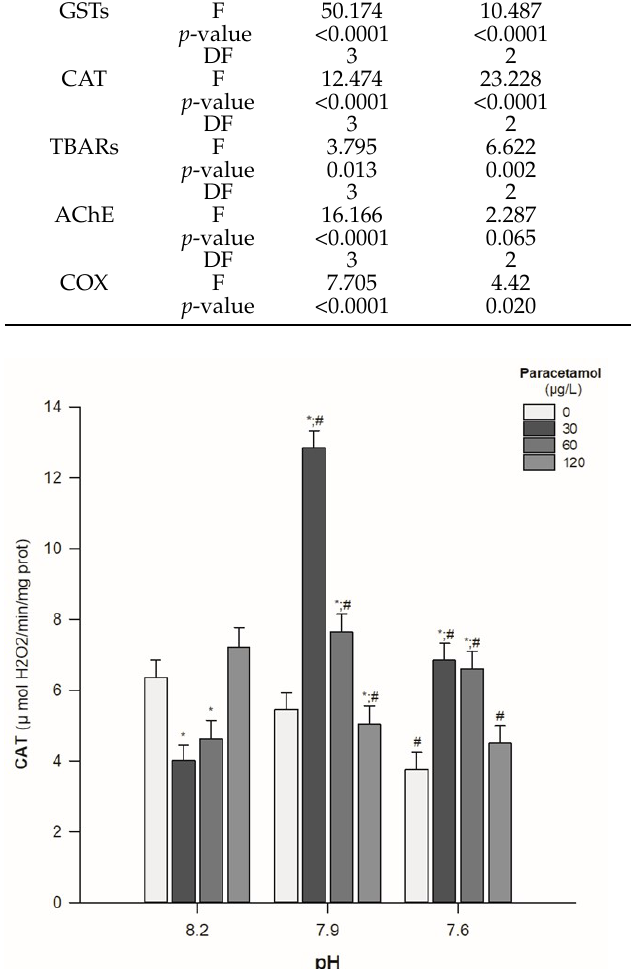
Figure 1. Catalase (CAT) activity in Hediste diversicolor exposed to paracetamol (0, 30, 60, and 120 µg/L) under the pH values of 8.2, 7.9, and 7.6. Statistical differences among PAR concentrations (30, 60, and 120 µg/L) and the control group (0 µg/L) are represented with “*”. Statistical differences between pH treatments (7.9 and 7.6) and the pH control group (8.2) within each PAR concentration are represented with “#”. Statistics refer to Dunnett’s tests (following a Two-Way ANOVA). Values are mean ± standard